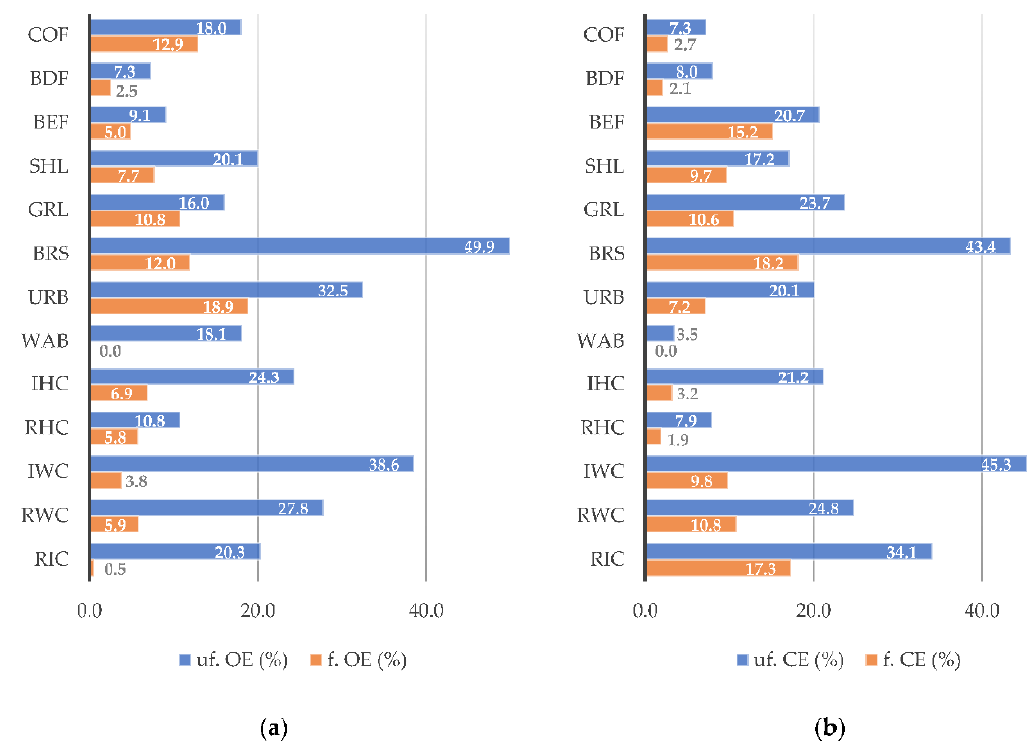
Figure 18. Comparison of the omission ( a ) error (OE) and commission ( b ) error (CE) regarding unfiltered (uf.) and filtered (f.) ground truth areas. Figures refer to SIOSE 2005 and LCM-2002 imagery.